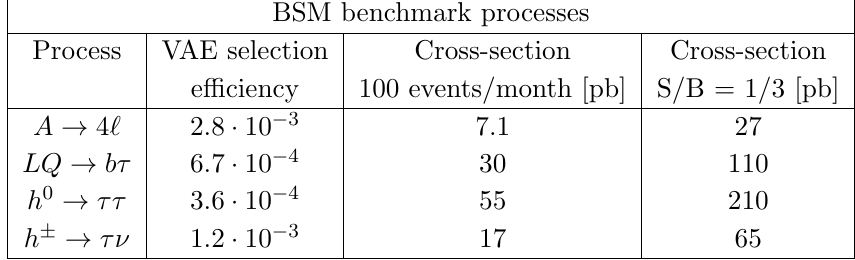
Table 4 . Breakdown of BSM processes e(cid:14)ciency, and cross section values corresponding to 100 selected events in a month and to a signal-over-background ratio of 1/3 (i.e., an absolute yield of (cid:24) 400 events/month). The monthly event yield is computed assuming an average luminosity per month of 5 fb (cid:0) 1 , computing by taking the LHC 2016 data delivery ( (cid:24) 40 fb (cid:0) 1 collected in 8 months). All quoted e(cid:14)ciencies are computed (cid:12)xing the VAE loss threshold (cid:15) SM = 5 : 4 (cid:1) 10 (cid:0) 6